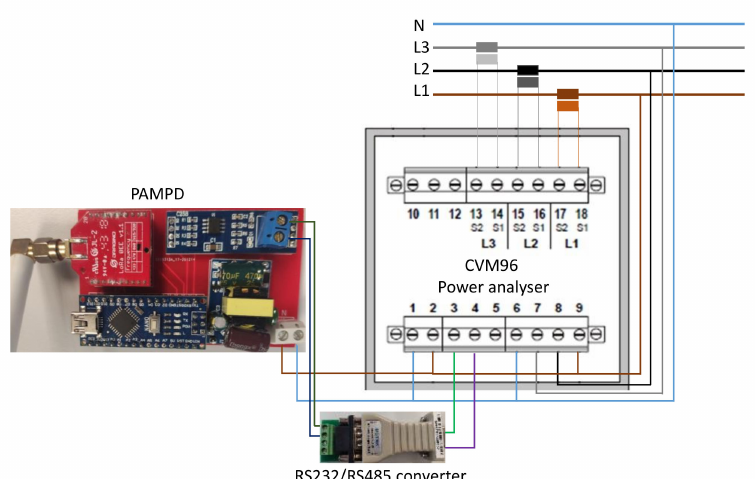
Figure 10. Wiring diagram for connecting the PAMPD with the CVM96 power analyzer into an electrical panel using RS232/RS485